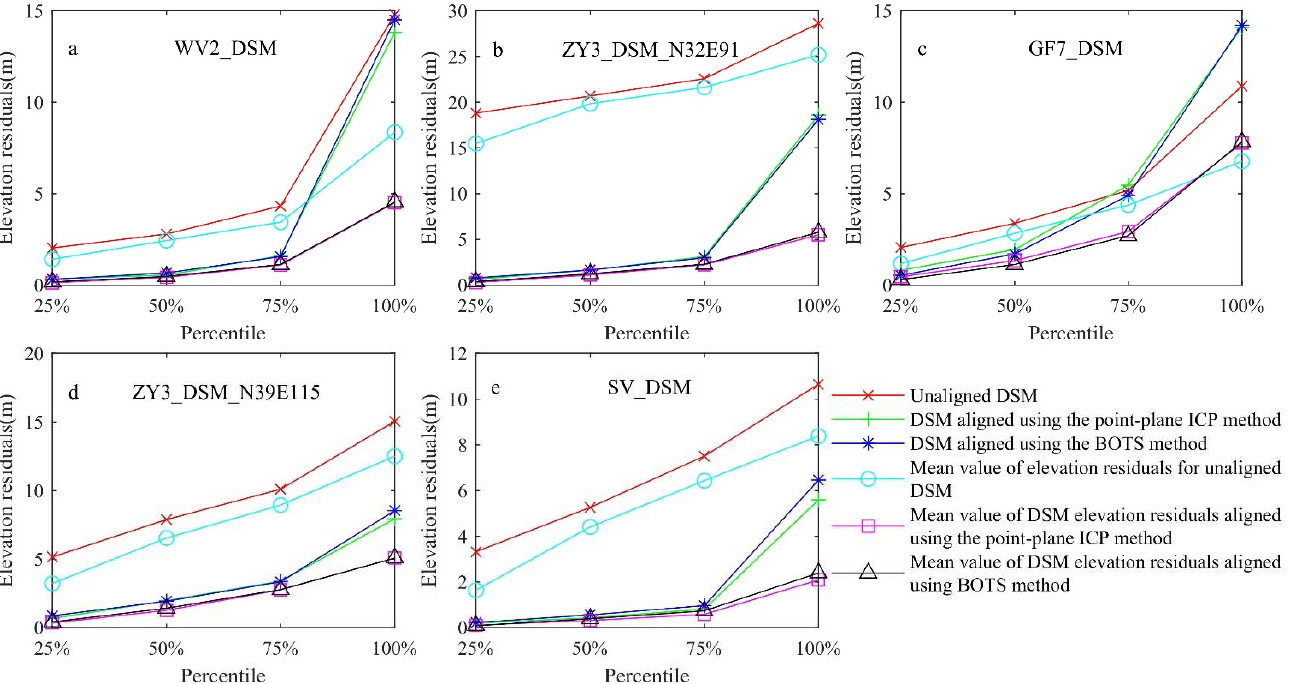
Figure 9. DSM elevation residual distribution: ( a – e ) is the absolute value of the elevation residual and the mean of the absolute value of the elevation residual at the quartile before and after the ICP and BOTS algorithms were used for registration.